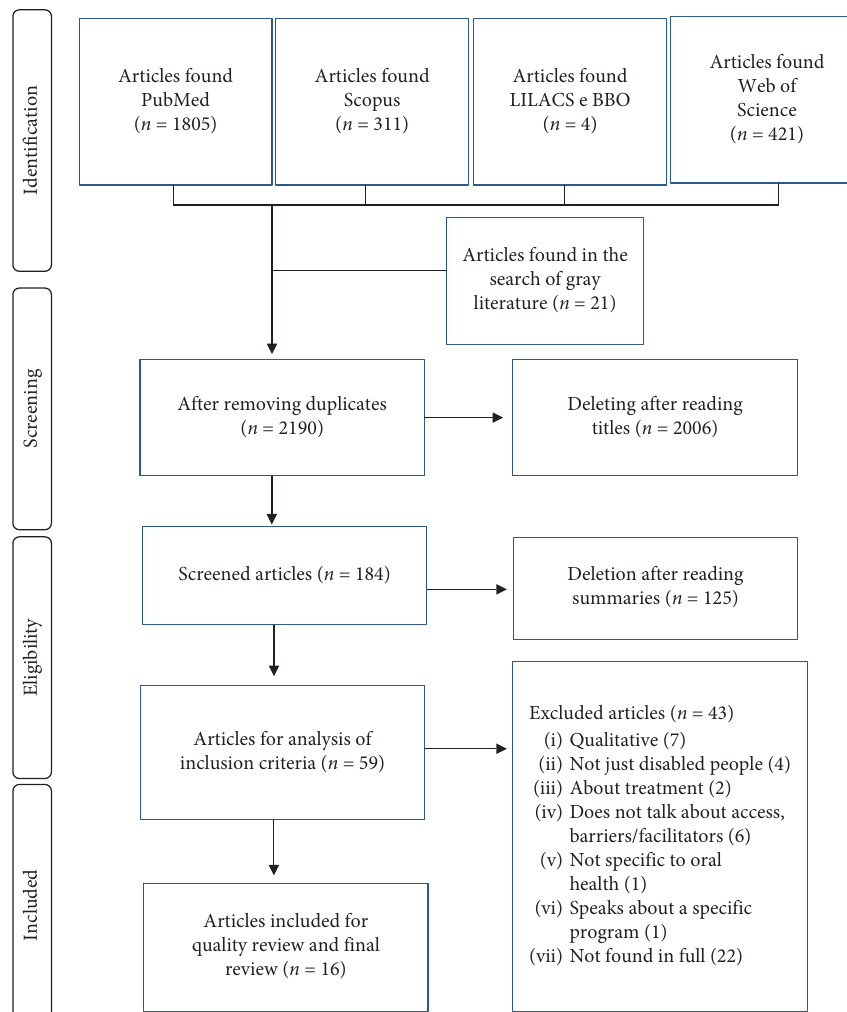
Figure 1: Flowchart of the study selection process according to the PRISMA